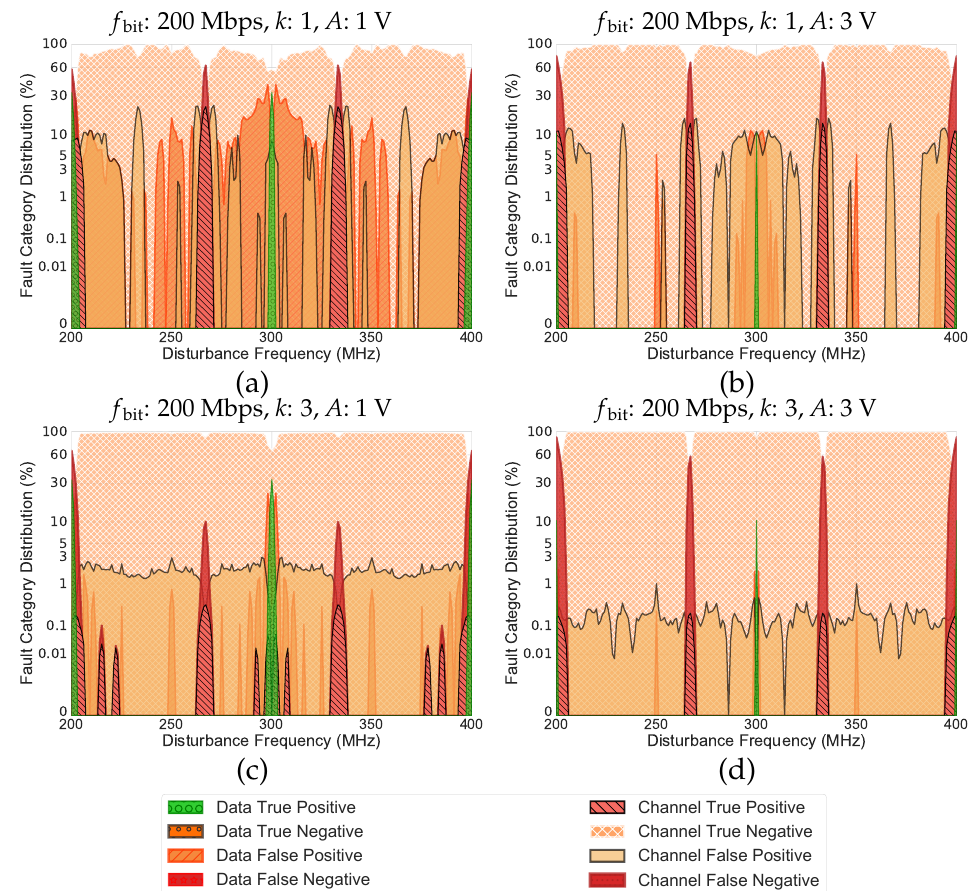
Figure 2. Reed–Solomon Codes Effectiveness under single-frequency electromagnetic disturbances for the symbol size of